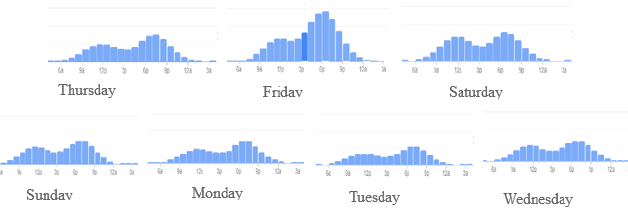
Figure 8. Average Time of Using/week: study of observing for 3 months to show the times where Bab Al Bahrain Avenue is used, afternoon and evening (google, 2018).